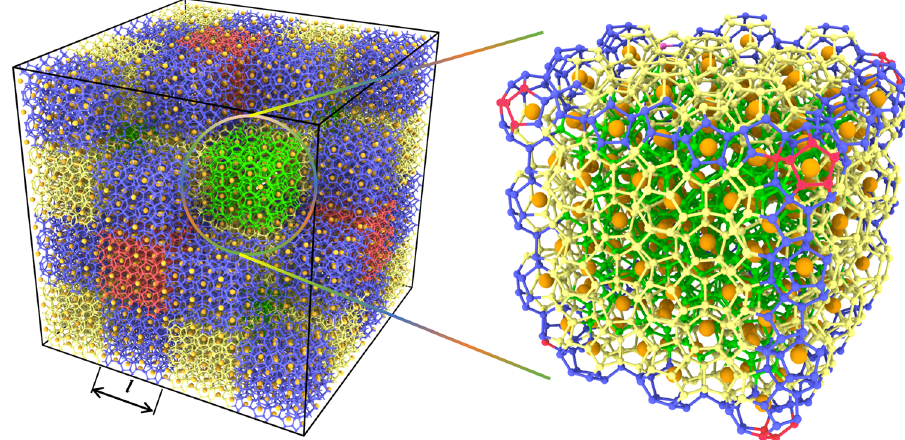
Figure 4: Cross - sectional view of segmentation of the clathrate hydrate system by HTR algorithm. Adjacent blocks are distinguished by di ff erent colors. The water molecules of di ff erent colors in the partially enlarged view come from the blocks adjacent to the central green